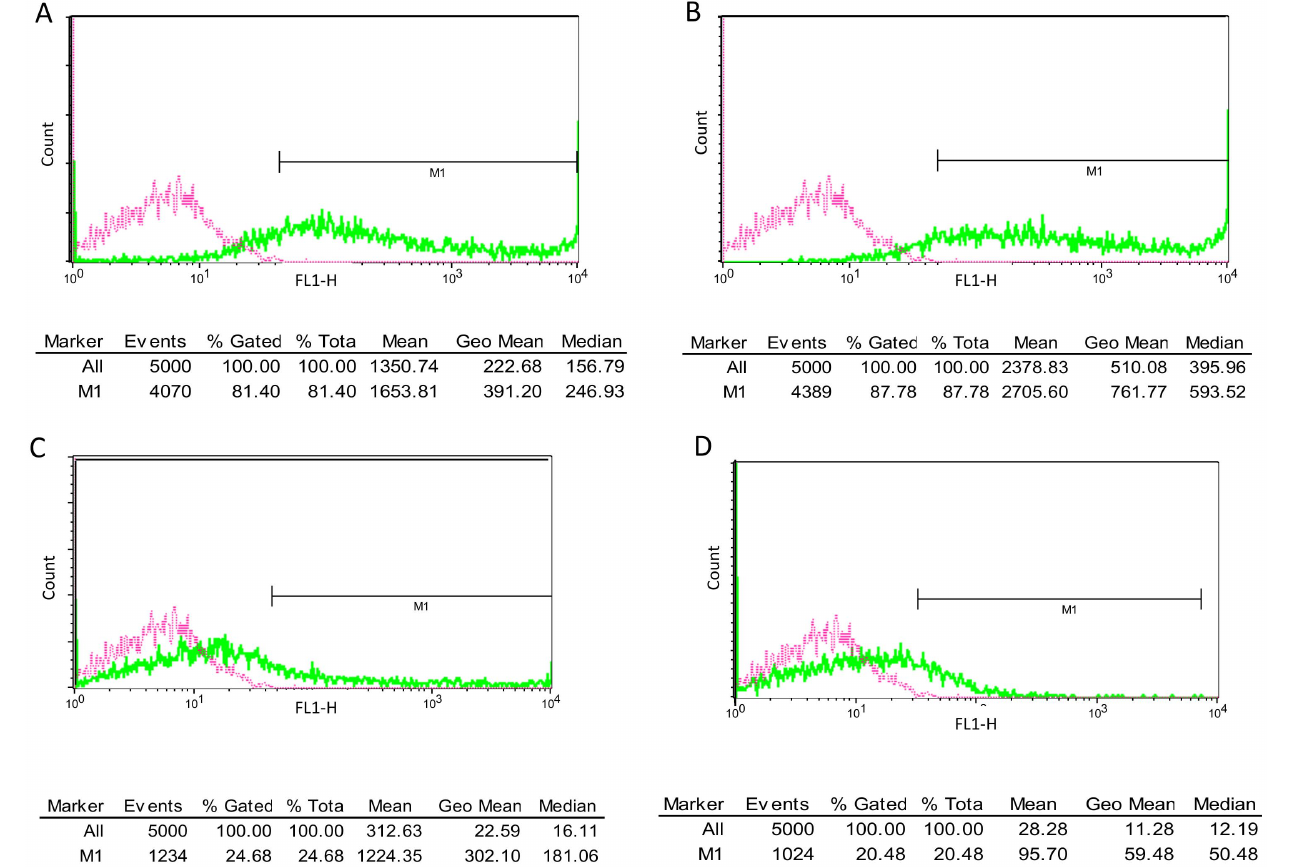
Figure 3. Flow cytometric detection of green fluorescent protein. A : number of gated cells following transfection using wild-type HIV-2 vector. B : number of gated cells following transfection with the vector modified for the cassette system. C : transduction using wild-type vector. D : transduction using the modified vector. A minimum of three experiments were carried and the data shown are representative samples of results acquired. Pink color indicates control cells.